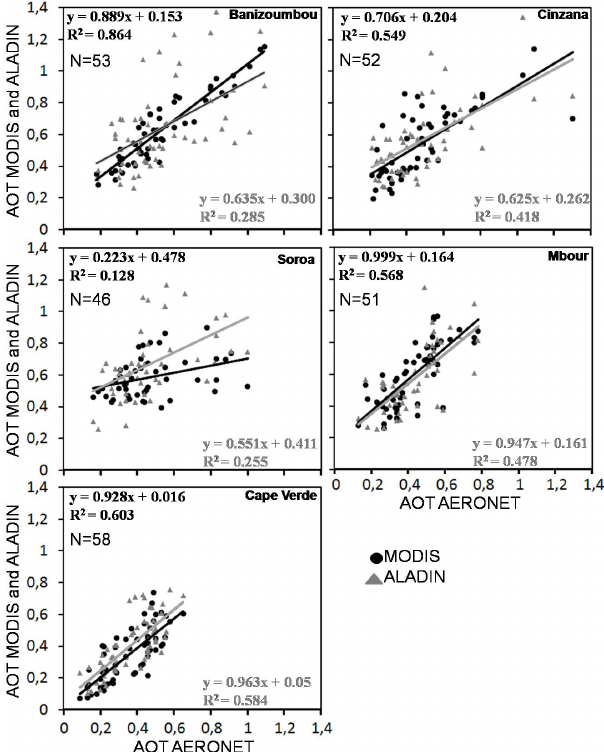
Figure 12. Scatter plot of monthly ALADIN (grey) and MODIS (black) aerosol optical thickness against AERONET measurements over Banizoumbou, Cinzana, Soroa, Mbour and Cape Verde from 2006 to 2010. In abscissa, AERONET measurements; in ordinate, ALADIN and MODIS AOTs. N is the number of averaged monthly data of AOT available from 2006 to 2010. Each marker represents the averaged monthly AOT from 2006 to 2010. R is the correlation